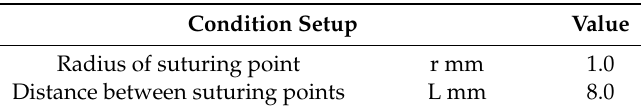
Table 3. Target point setup.